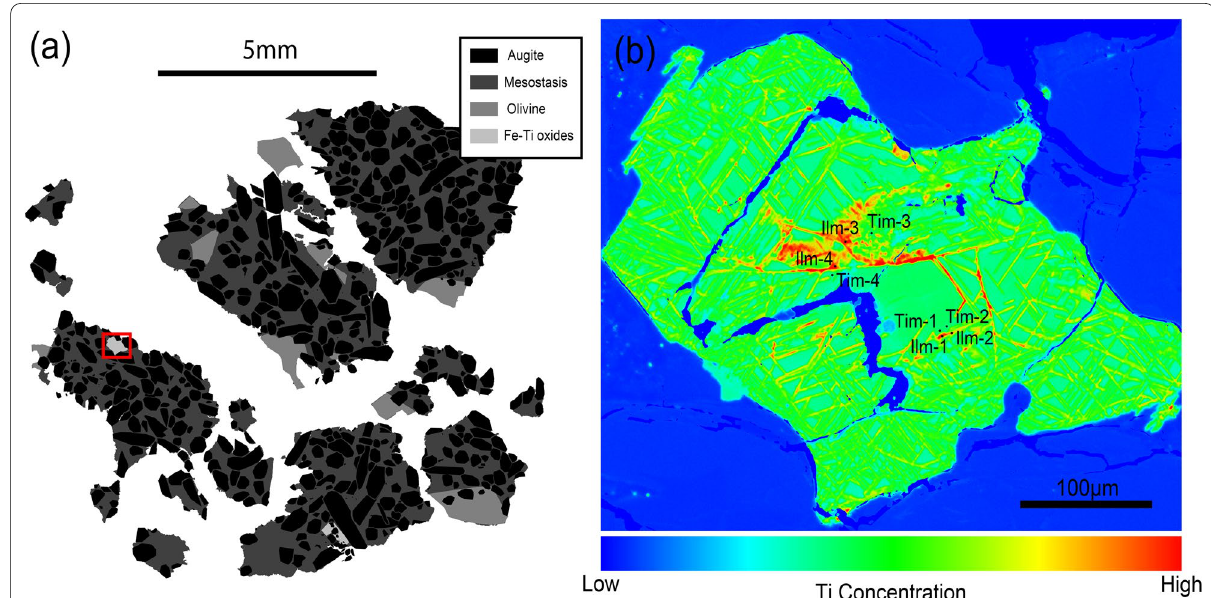
Fig. 1 a Hand-traced images of NWA 5790 sample in this study. Augite, Fe–Ti oxides, olivine, and intercumulus phase are shown in black, light grey, middle grey, and dark grey, respectively. b The false-colour Ti element image of representative Fe–Ti oxides in NWA 5790 zoomed from the red rectangle in the image ( a )